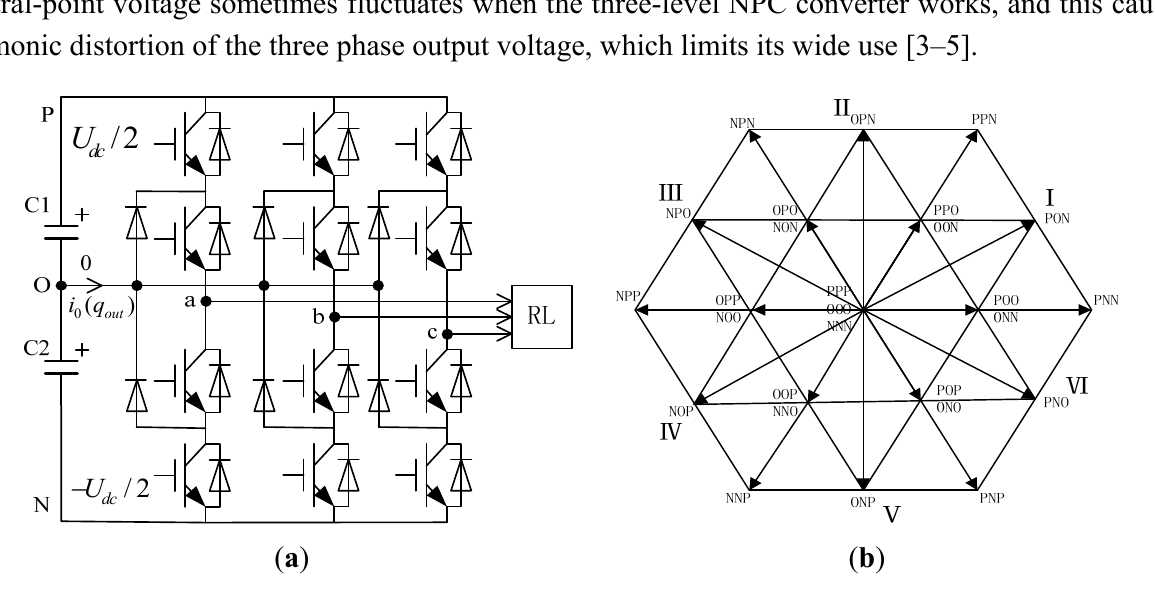
Figure 1. Schematic of a three-level NPC converter. ( a ) Topology structure of three-level NPC converter; ( b ) Distribution diagram of voltage